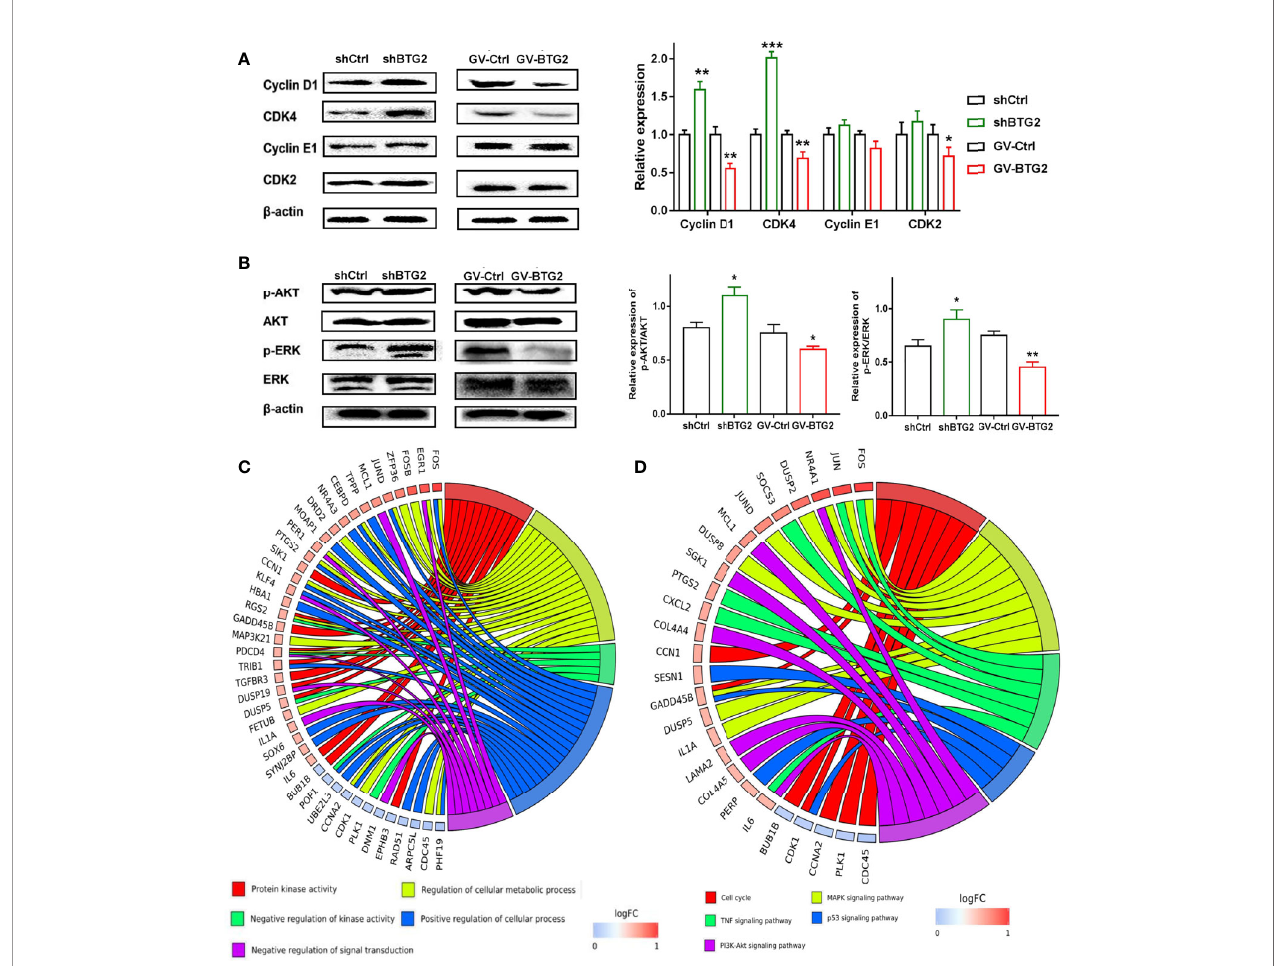
FIGURE 5 | BTG2 inhibited ovarian cancer proliferation through the AKT and ERK-MAPK signaling pathway. (A) Protein levels of Cyclin D1, CDK4, Cyclin E1 and CDK2 were determined by Western blot on the left side. The ratios of Cyclin D1, CDK4, Cyclin E1, CDK2, were relative to b -actin and normalized to non-treated control group on the right side. (B) Protein levels of p-AKT, AKT, p-ERK1/2 and ERK1/2 were determined by Western blot on the left side and The relative expression of p-AKT/AKT and p-ERK/ERK of shBTG2 cells and GV-BTG2 cells was on the right side. Data were presented as means ± SD of three independent experiments compared to the negative control group. (C) GO Chord plot of 5 signi fi cantly ranked represented GO terms belonging to the Biological Process subontology for BTG2 downstream genes. (D) KEGG Chord plot of 5 signi fi cantly ranked represented KEGG pathways for BTG2 relative downstream genes. *p < 0.05, **p < 0.01, ***p